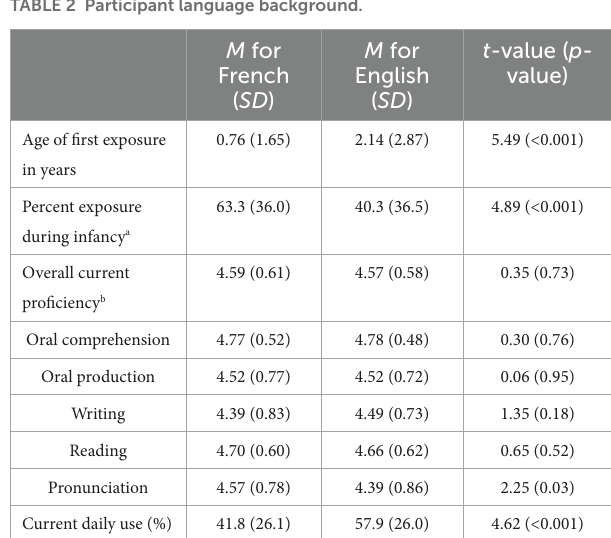
TABLE 2 Participant language